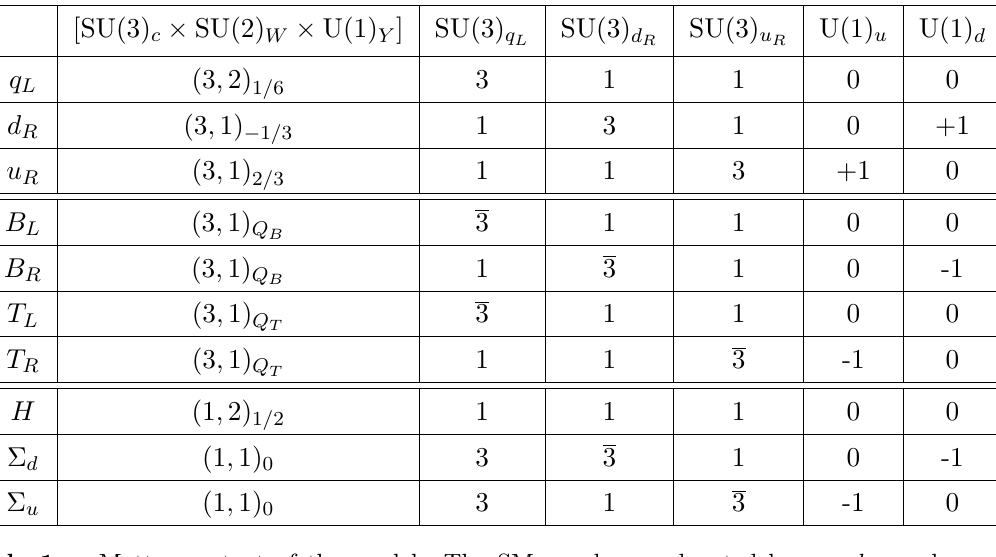
Matter content of the model. The SM quarks are denoted by q L , d R , and u R and arranged in triplets of the MFV non-Abelian flavor group. B L,R and T L,R are vector-like down-like and up-like quarks arranged in MFV anti triplets. The hypercharges Q B and Q T with Q B 6 = Q T are kept as general parameters with Q B = − 1 / 3 and Q T = +2 / 3 to have new fermions match the electric charges of down-type and up-type quarks. The last three rows contain the scalar particles with Σ u and Σ d as SM gauge singlets that spontaneously break the MFV group and CP. All global flavor symmetries do not have a mixed anomaly with SU(3) c